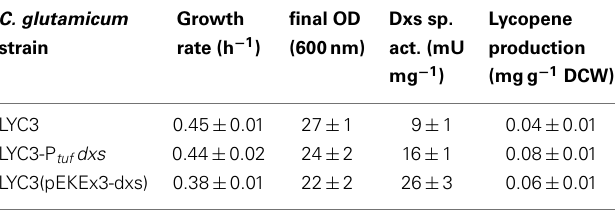
Table 3 | Influence of chromosomal promoter exchange of